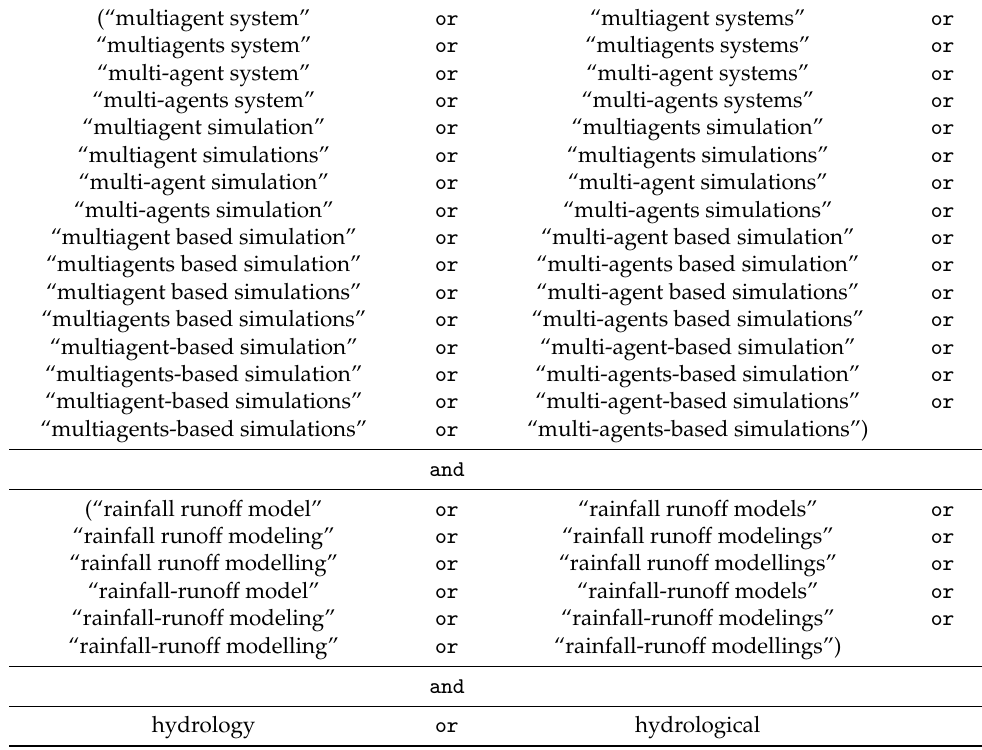
Table 4. SLR protocol: strings defined by keywords variations.